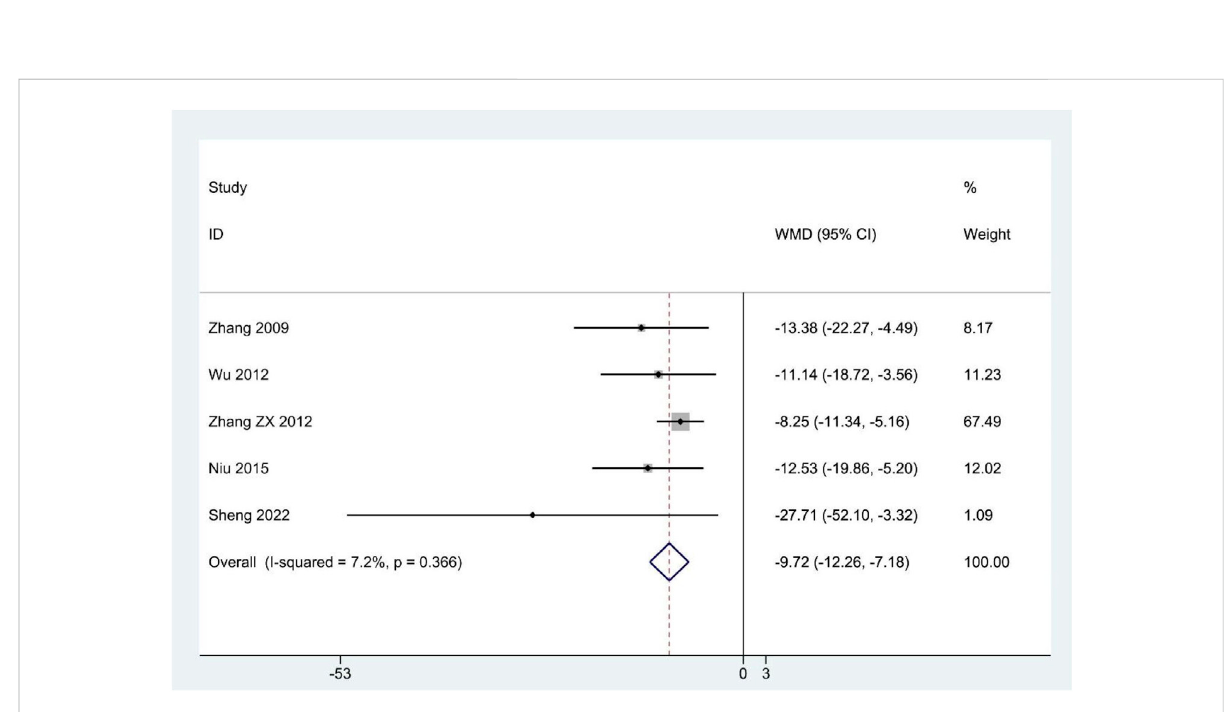
FIGURE 4 Forest plot for SCL-90